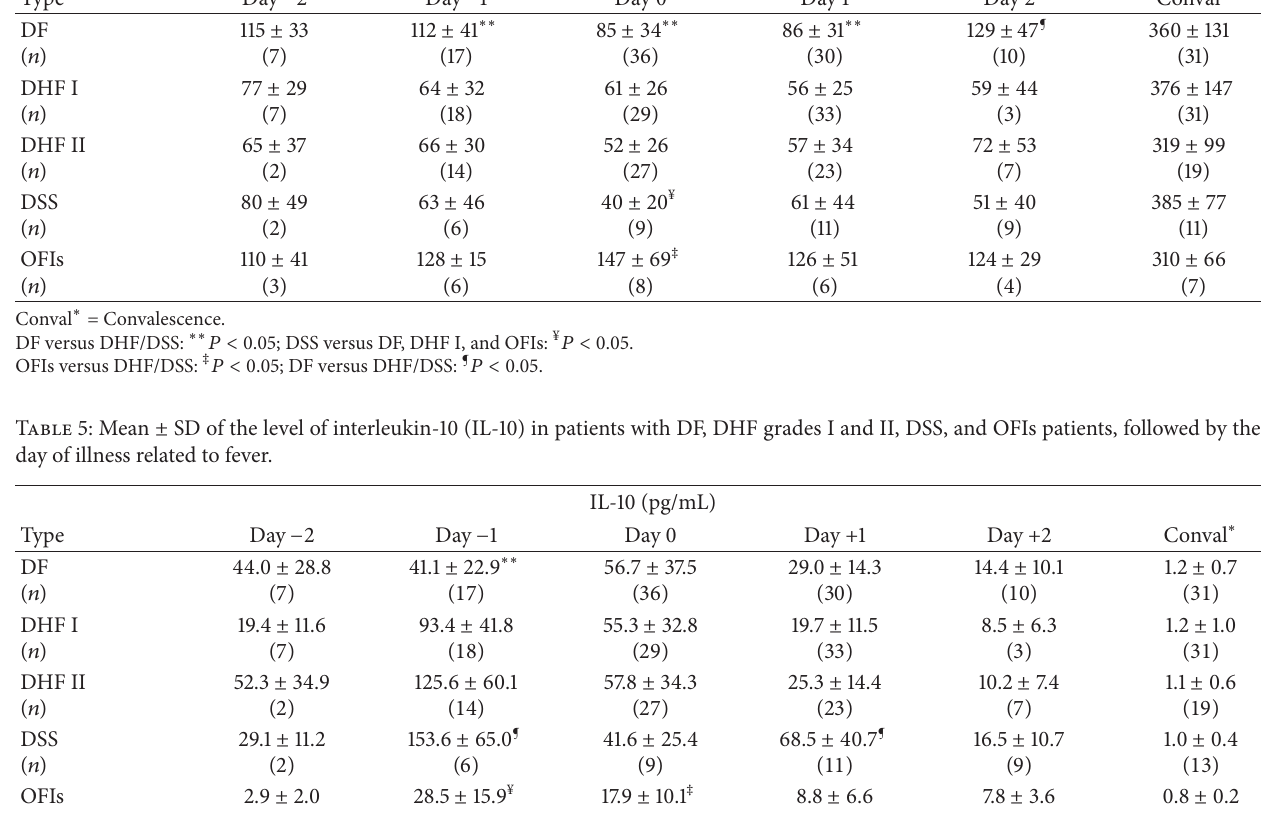
Table 4: Mean ± SD of platelet counts in DF, DHF grades I and II, DSS, and OFIs patients, followed by the day of illness related to fever. Platelet count ( × 10 6 /L)